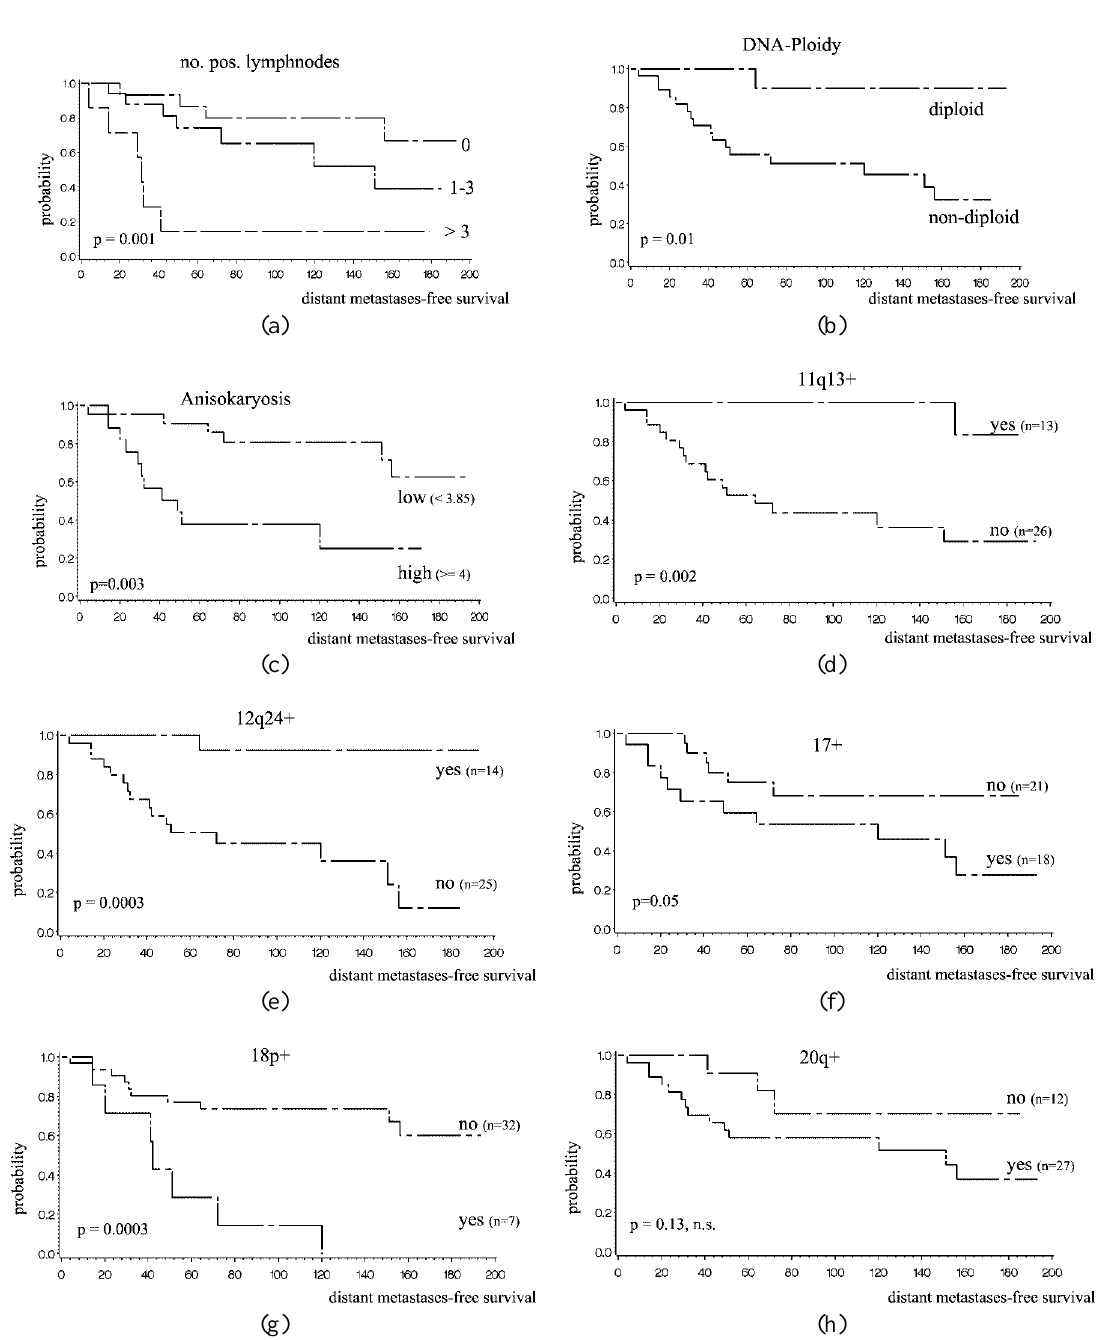
Fig. 2. Kaplan–Meier curves for a metastases-free survival of patients stratified according to the number of positive lymph nodes, DNA ploidy, anisokaryosis, and the chromosomal alterations on 11q13, 12q24, 17, 18p, and 20q. Gain on 20q, which was not significant in univariate analysis, is demonstrated because of it’s suggested prognostic value in other studies